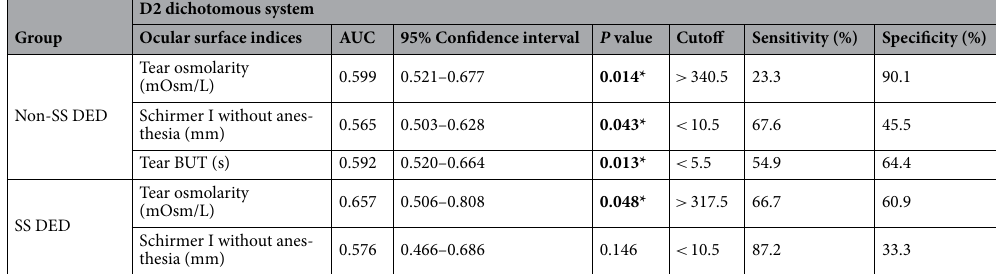
Table 7. ROC curve analysis of positive tear matrix metalloproteinase 9 (MMP-9) according to D2 dichotomous system with the ocular surface indices in subjects with dry eye disease (DED) with and without primary Sjogren’s syndrome (pSS). * P < 0.05. AUC, area under curve. BUT, break-up time. Significant are in value